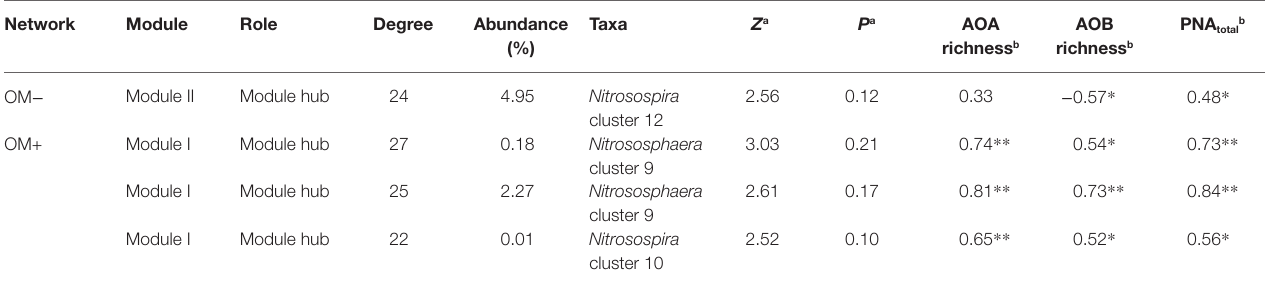
TABLE 2 | Potential keystone taxa in the AOA and AOB networks based on treatments without (OM − ) and with (OM+) organic material amendments. Network